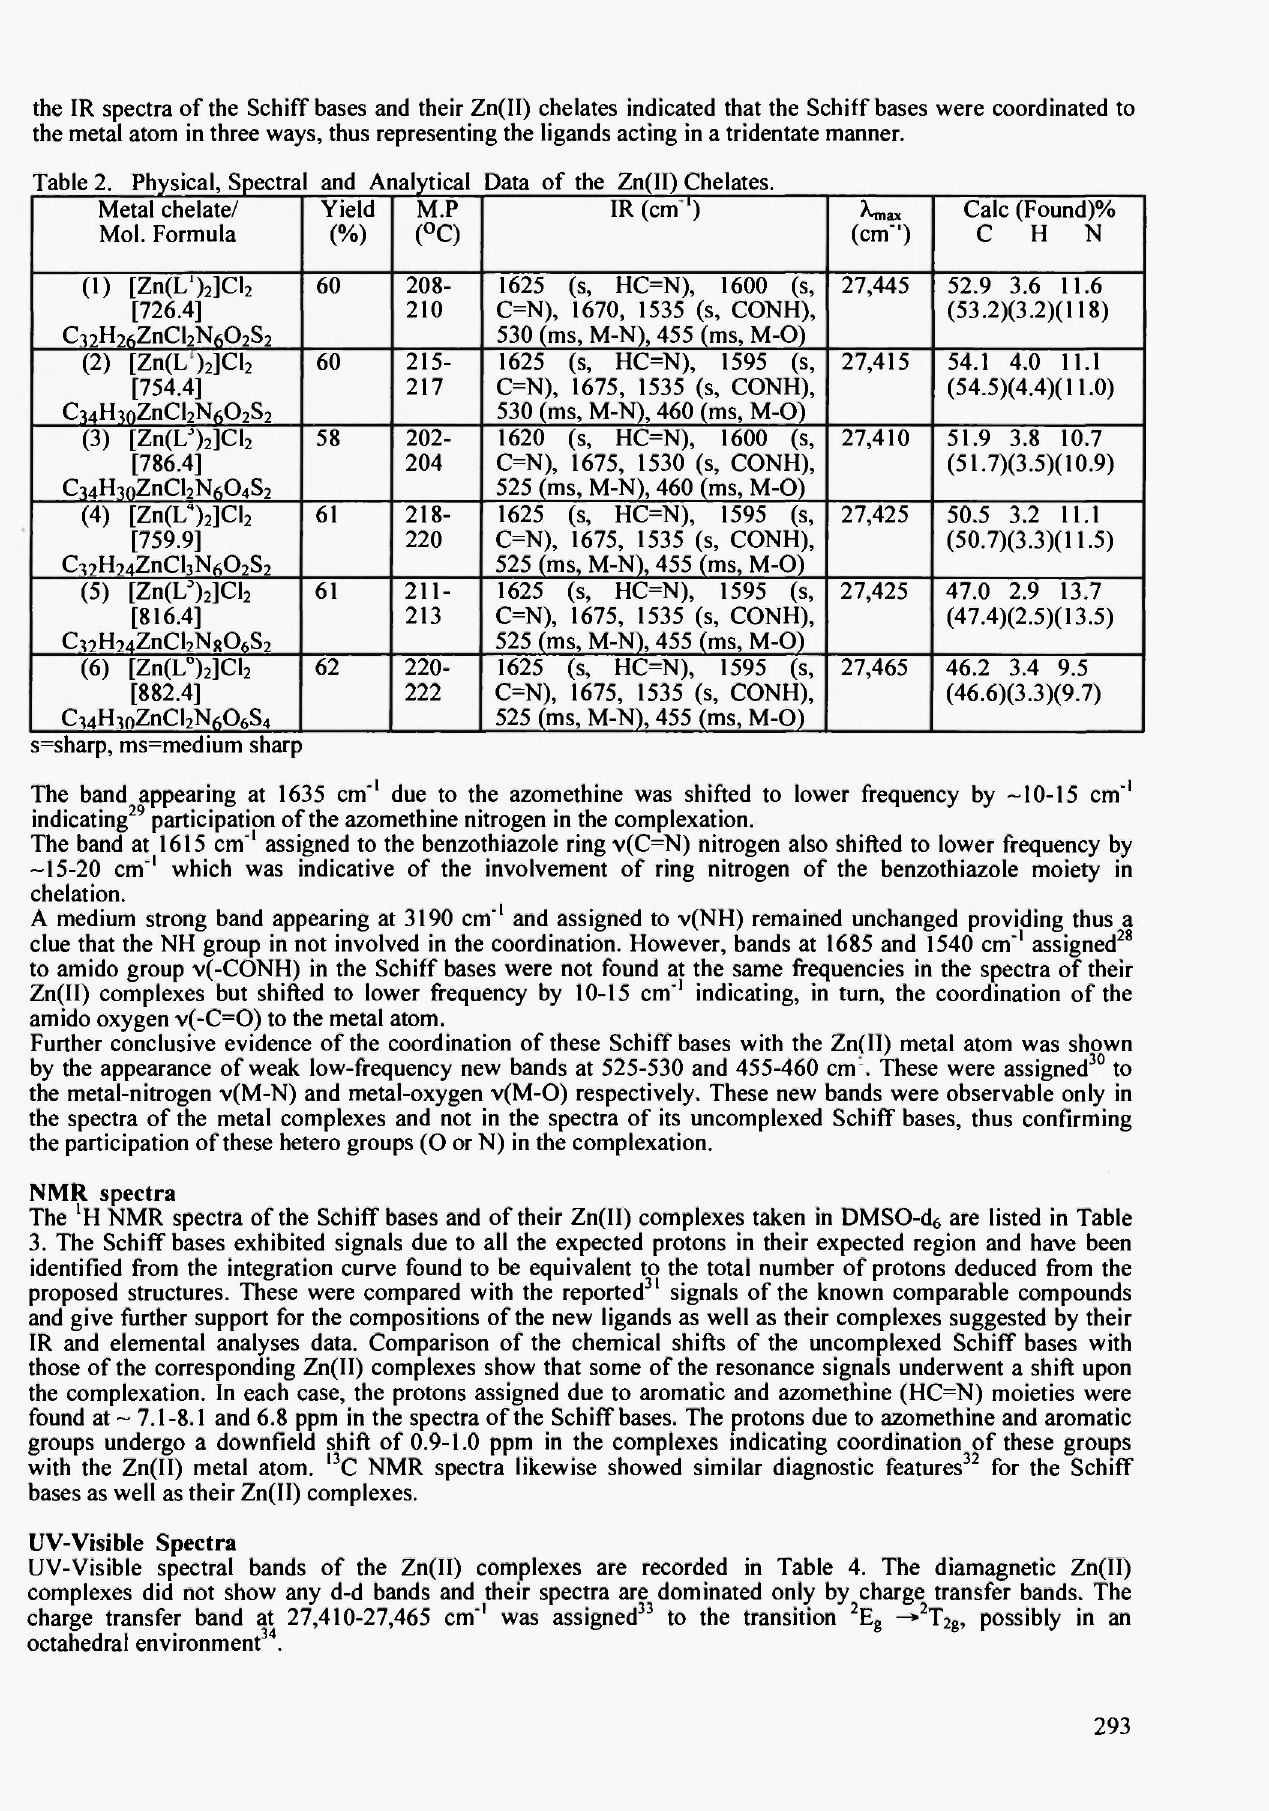
Table 2. Physical, Spectral and Analytical Data of the Zn(II) Chelates. Metal chelate/ Mol. Formula